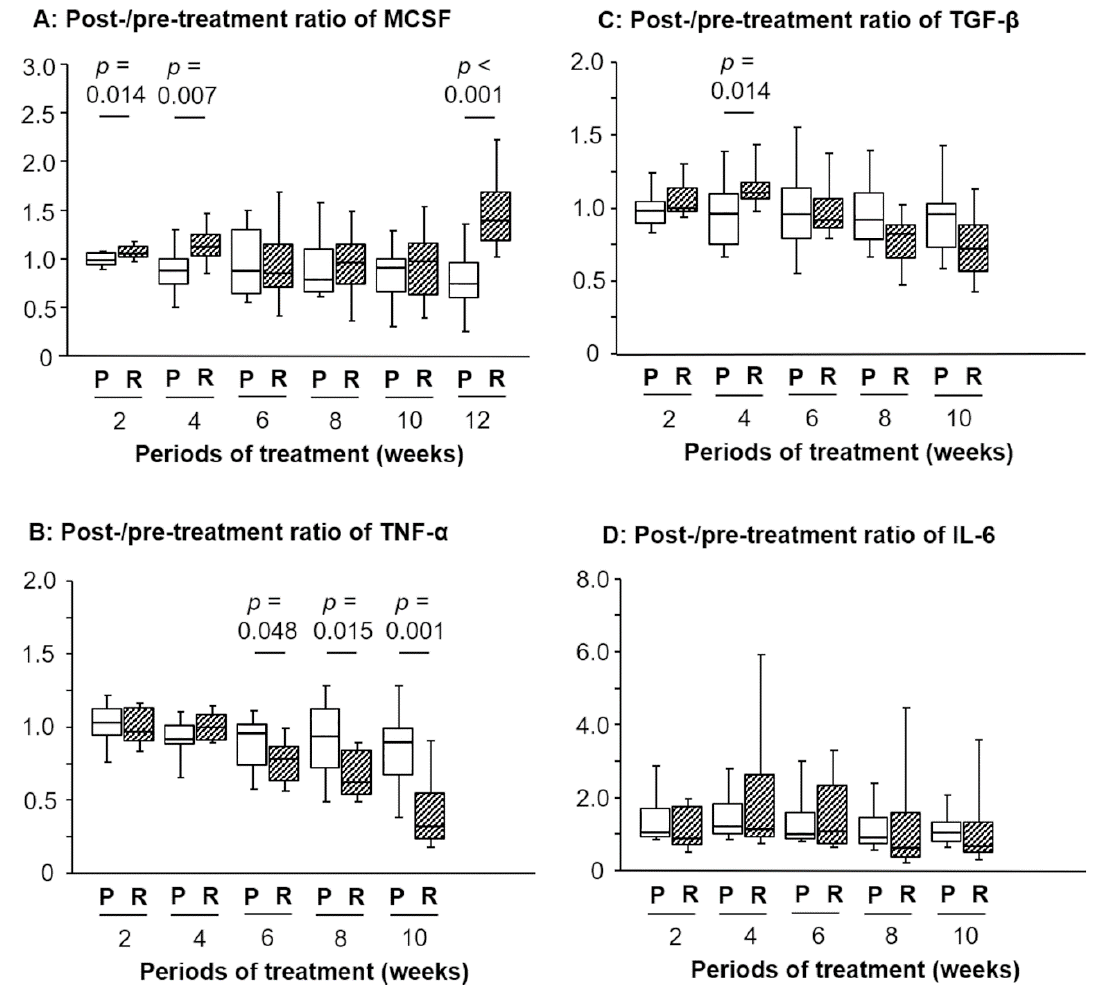
Figure 1. Temporal changes in the post- / pretreatment ratio of the serum levels of macrophage colony stimulating factor (M-CSF), tumor necrosis factor (TNF)- α , transforming growth factor (TGF)- β , or interleukin (IL)-6 after oral intake of royal jelly (RJ). A significant di ff erence was detected in the ratios between the placebo (P) and R group regarding: M-CSF after 2, 4, and 12 weeks ( A ), TNF- α from 6 to 10 weeks ( B ), and TGF- β after 2 weeks ( C ). No significant di ff erence was observed in the IL-6 ratios between the P and R group ( D ). The 12-week data of TNF- α , TGF- β , and IL-6 are shown in our previous report [7].